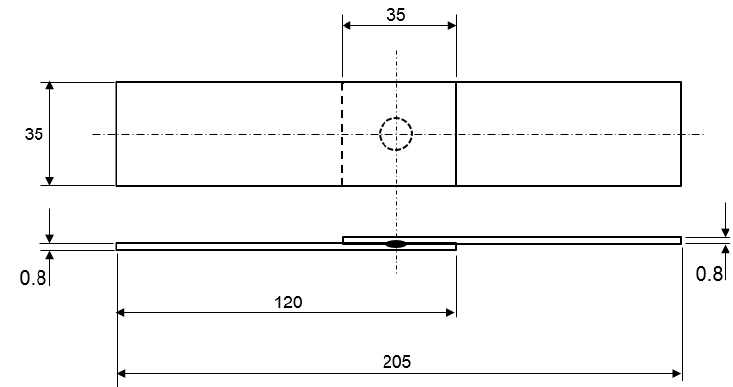
Figure 3. Schematic drawing (mm) of the test specimens used in the experiments, dimensions based on AWS B4.0 standard.